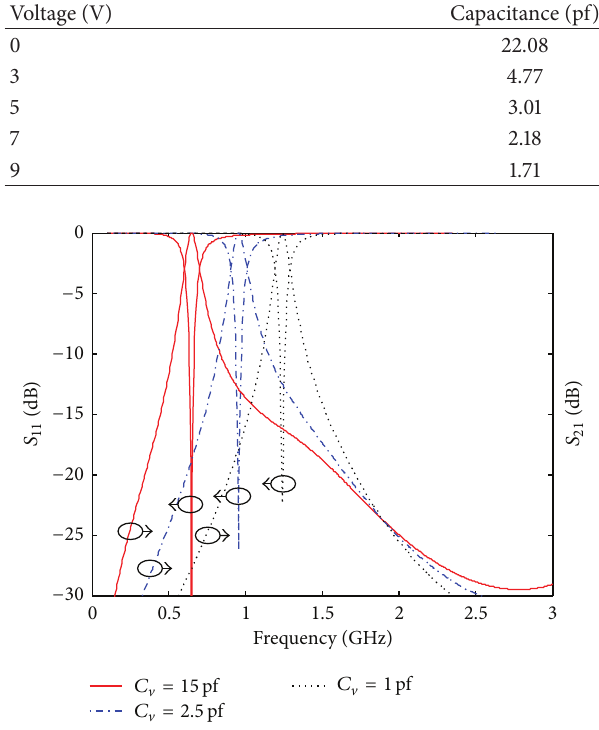
Figure 5: Calculated 𝑆